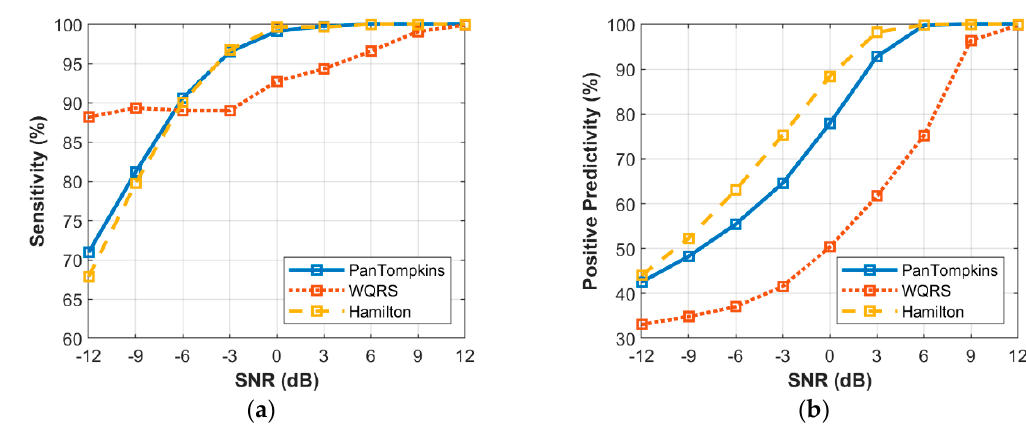
Figure 8. Relationship between the performance of beat detection and EM artefact for the record 100: ( a ) sensitivity with SNR; ( b ) positive predictivity with SNR.